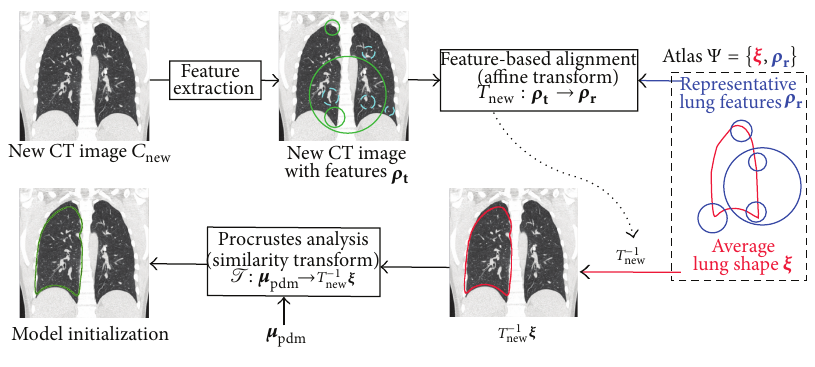
Figure 3: Schematic diagram showing the model initialization process for a new CT image. Features 𝜌 t are shown superimposed on the coronal slice of a CT image. Features matching with representative lung features 𝜌 r are marked with a solid line while the others are marked with a dashed line. For sake of clarity, the above process is shown only for the right